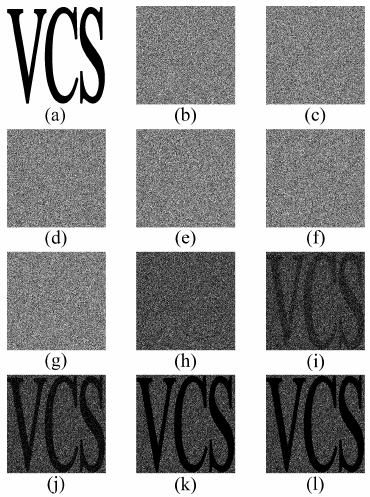
Figure 2. An experiment of Yan et al.’s (3, 6)-VCS. ( a ) secret image; ( b – g ) six shadows; ( h ) revealed image by two shadows; ( i ) revealed image by three shadows; ( j ) revealed image by four shadows; ( k ) revealed image by five shadows; and, ( l ) revealed image by six